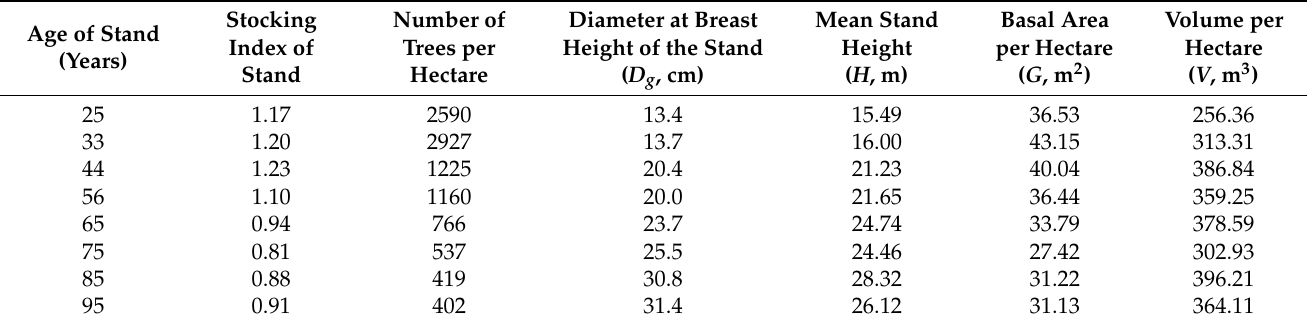
Table 1. Structural characteristics of stands.